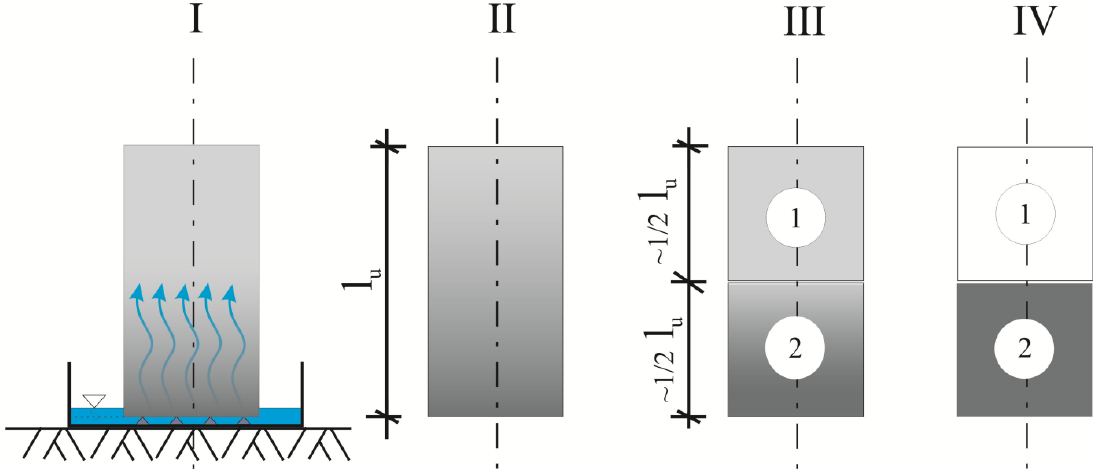
Figure 1. The scheme developed in-house showing the successive stages of preliminary experimental work, marked with symbols I, II, III and IV.